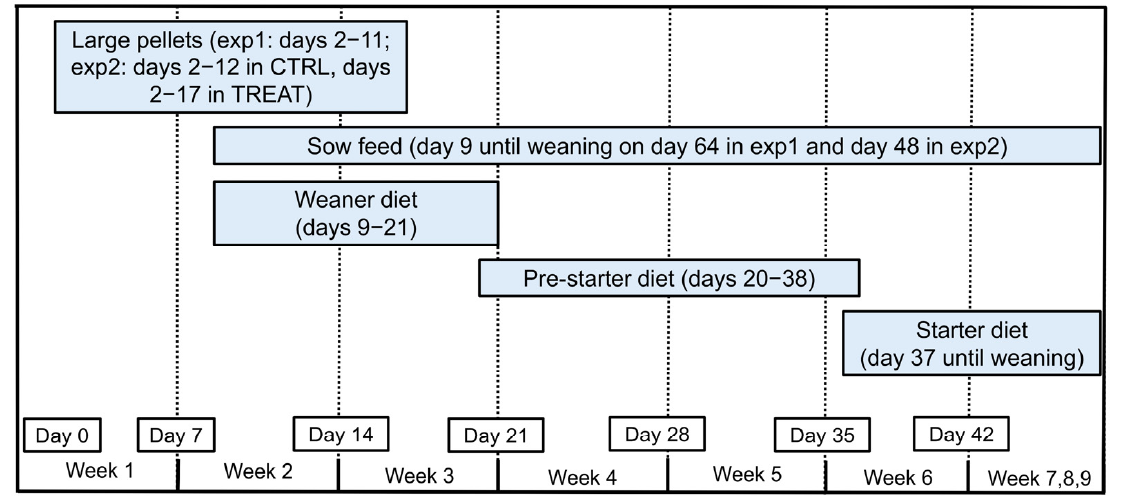
Figure 2. The general feeding management of piglets during lactation in the multi-suckling system. The sows were fed twice daily at 08:00 and 16:00. From voluntary IS (day 35